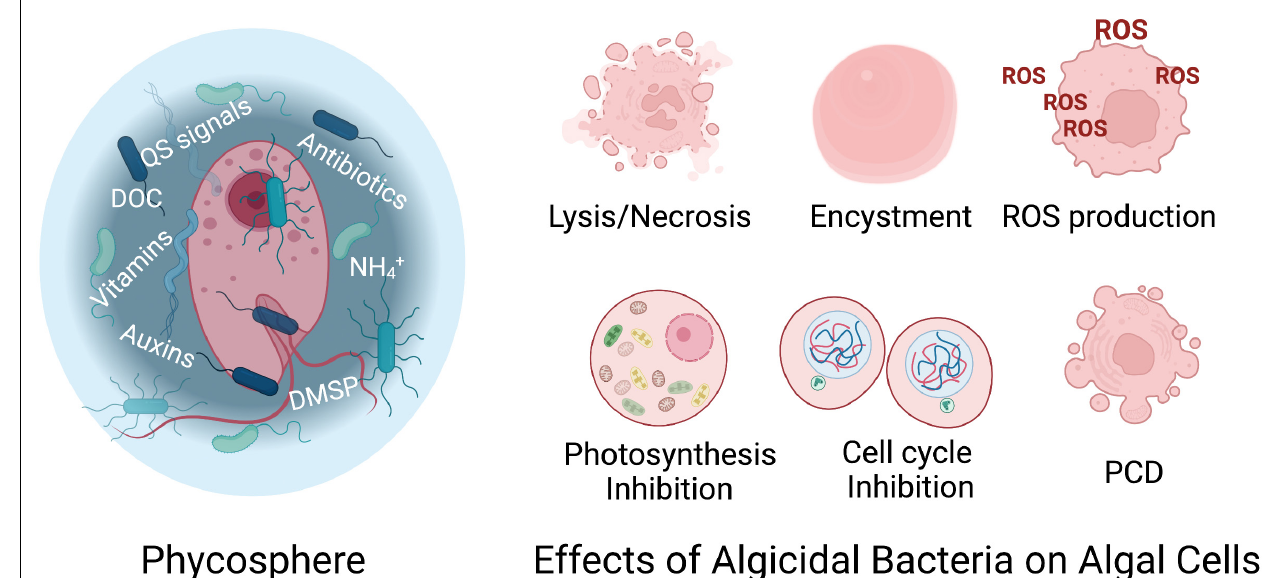
FIGURE 1 | (Left) Bacteria-algae interactions occur in the phycosphere where chemicals are exchanged. Algicidal bacteria may exert control over algal cell growth and viability through direct physical contact or indirectly through production of algicidal compounds. (Right) Algal response to algicidal bacteria varies. Algicidal interactions may cause lysis, or necrosis, in which the algal cell is lysed through chemical or physical means. Algal cells may also form temporary cysts as a defense mechanism. Chemical compounds produced by algicidal bacteria may induce production of reactive oxygen species (ROS), impact photobiology, inhibit cell cycle progression and/or induce programmed cell death (PCD), or apoptosis, in phytoplankton. DOC, dissolved organic carbon, QS, quorum sensing; DMSP, dimethylsulfoniopropionate. See text for details. Created with BioRender.com.